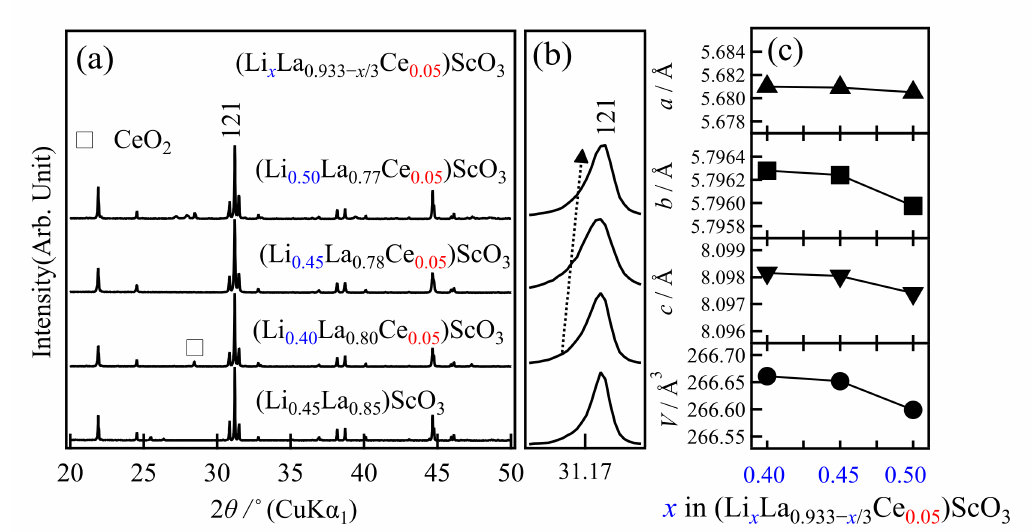
Figure 4. Variation in ( a , b ) the X-ray diffraction patterns, and ( c ) the lattice parameters based on the composition of the as-prepared (LixLa0.933 − x/3Ce0.05)ScO3 (x = 0.4, 0.45, and 0.50).